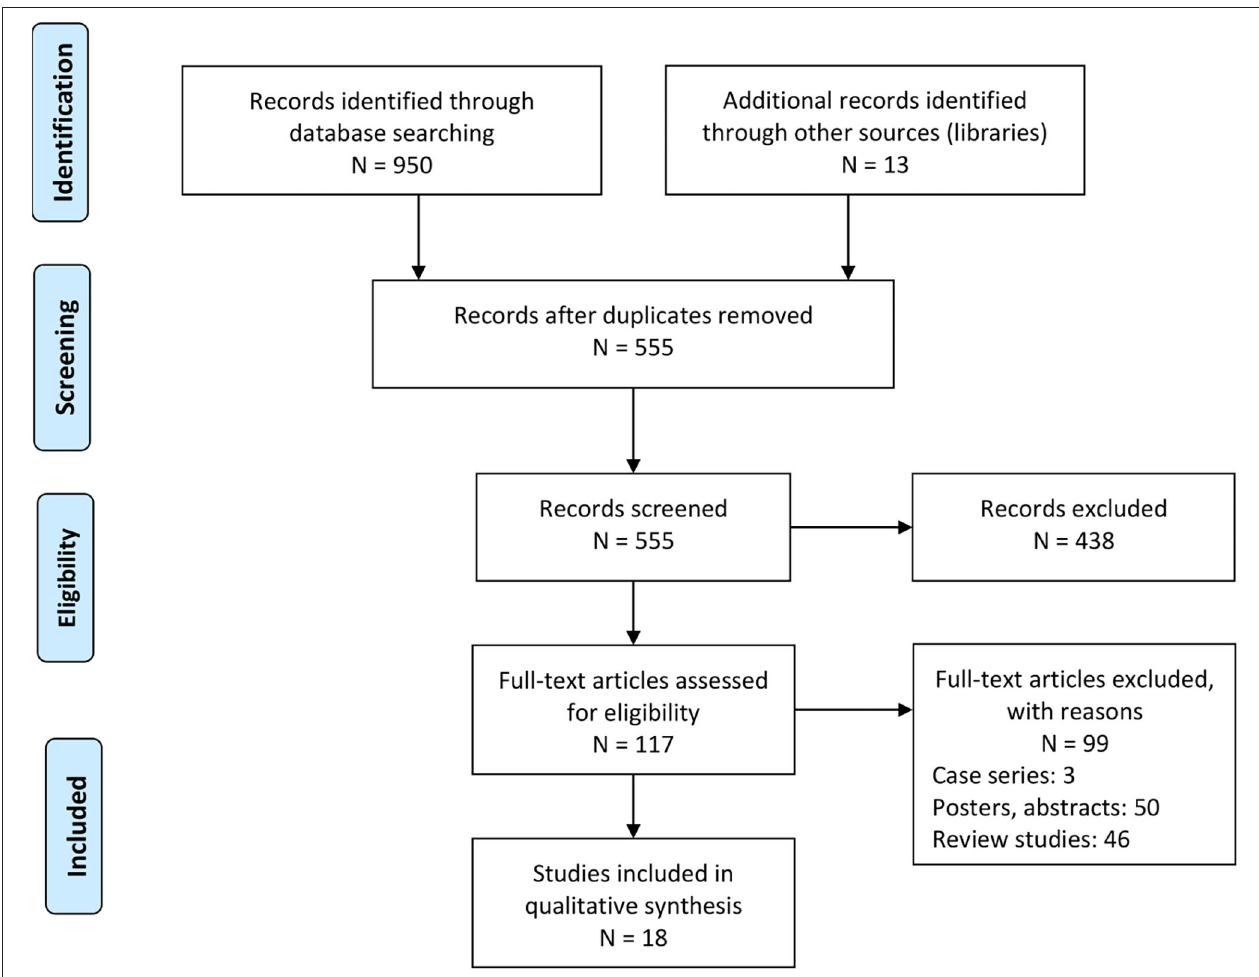
FIGURE 1 | PRISMA